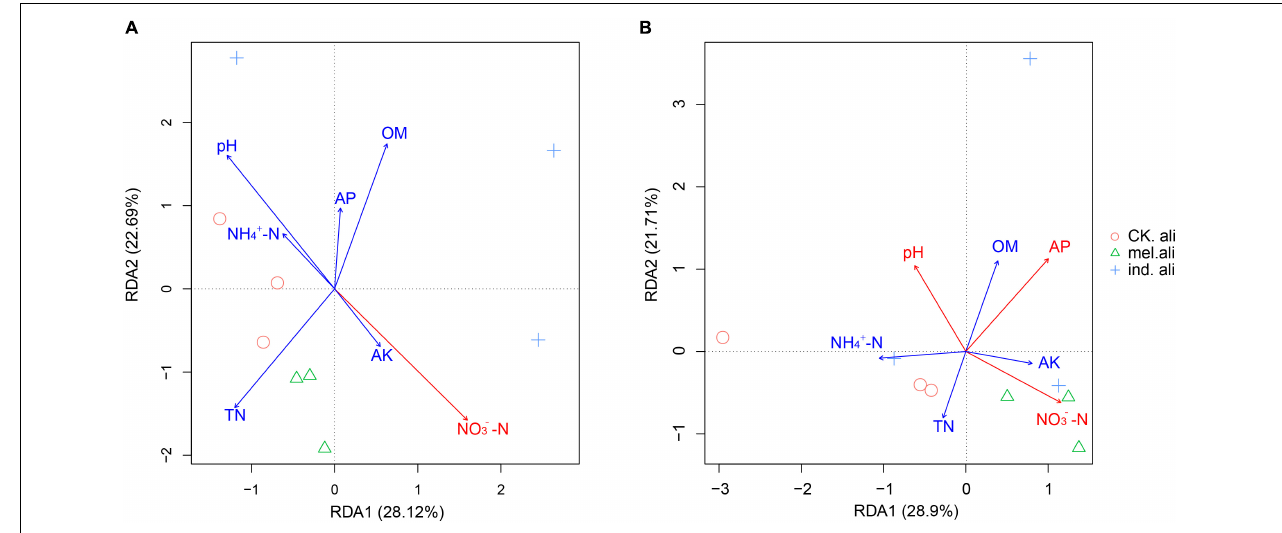
FIGURE 6 | Redundancy analysis (RDA) between (A) nirK - and (B) nirS -type denitrifying bacterial communities and soil factors in the rhizosphere soil of Quercus aliena . CK.ali, rhizosphere soil of Q. aliena without Tuber partner; mel.ali, ectomycorrhizosphere soil of Q. aliena with Tuber melanosporum partner; and ind.ali, ectomycorrhizosphere soil of Q. aliena with Tuber indicum